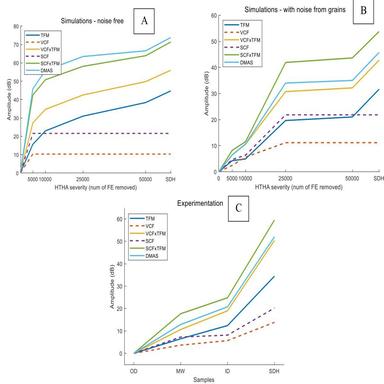
Maximum amplitude of HTHA ROI and SDH compared with a flaw-free zone for: A) isotropic and B) anisotropic simulations, as well as C) experiments.